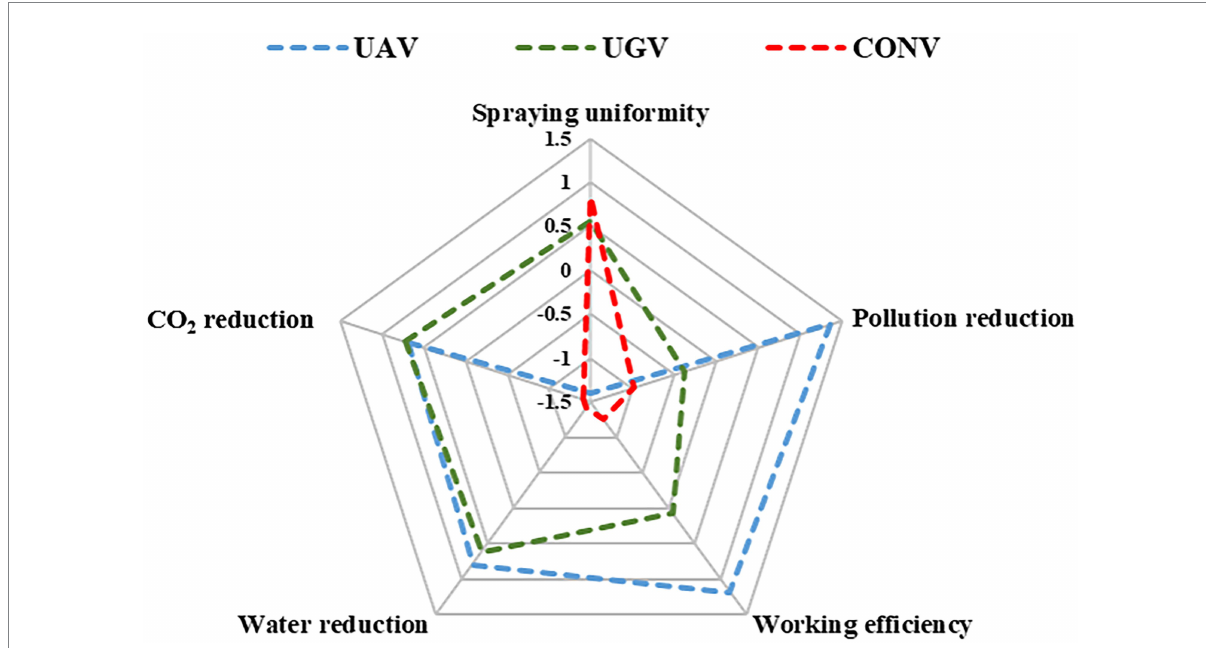
FIGURE 6 Comprehensive comparison of characteristics in different pesticide application techniques. Blue line represents unmanned aircraft vehicle technique (UAV), green represents unmanned ground vehicle technique (UGV) and red line represents conventional manned technique (CONV). Data was normalized and 0 represents the average value of each column. Positive values represent performance above average in each column whereas negative values represent performance below